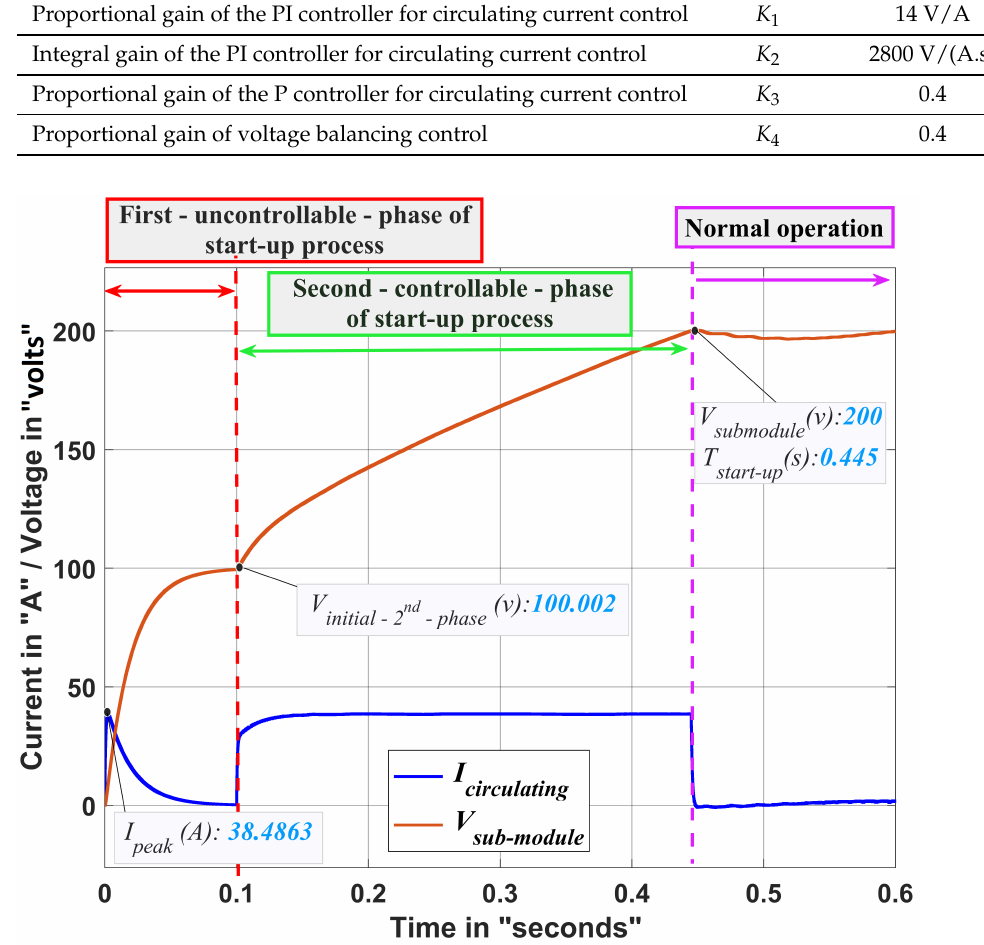
Figure 4. The conventional start-up precharging method applied on a single-phase